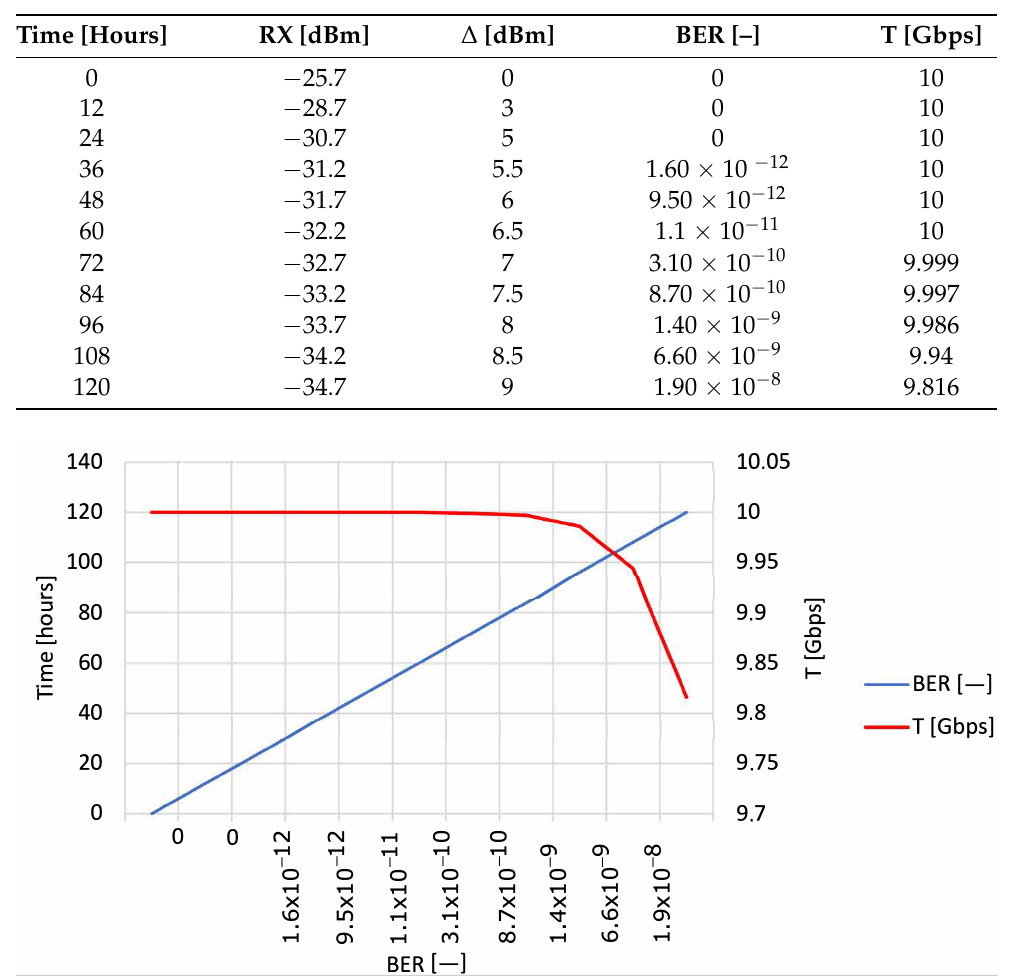
Figure 7. BER and data throughout on real optical